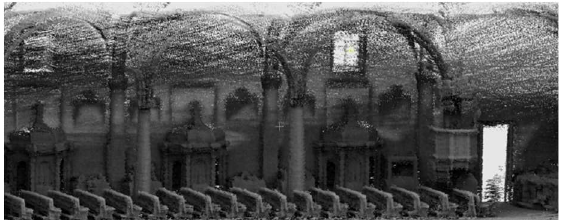
Figure 6. KAARTA Stencil 2 dataset obtained following the first path: the 3D point cloud (top of the image) and the estimated trajectory (lower part of the image).